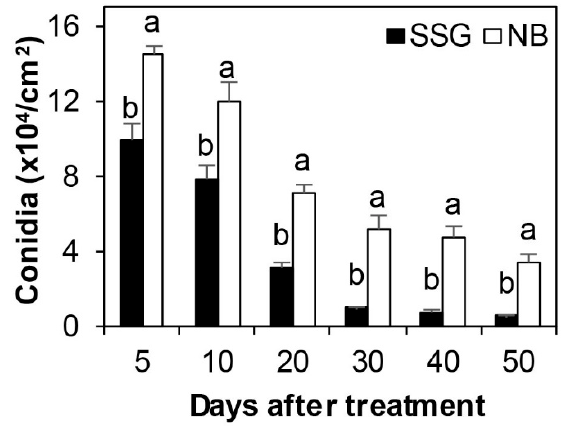
Figure 6. SSG reduced sporulation by Calonectria pseudonaviculata on blighted leaves for a range of time after they were placed under healthy plants then cover sprayed with SSG suspension at 10 8 cells/mL (SSG) or with nutrient broth (NB) as a control. Each column depicts an average of six replicates from two experimental runs and is topped with a standard error bar. Columns marked with different letters within each sampling time differed according to the LSD test at p = 0.05.